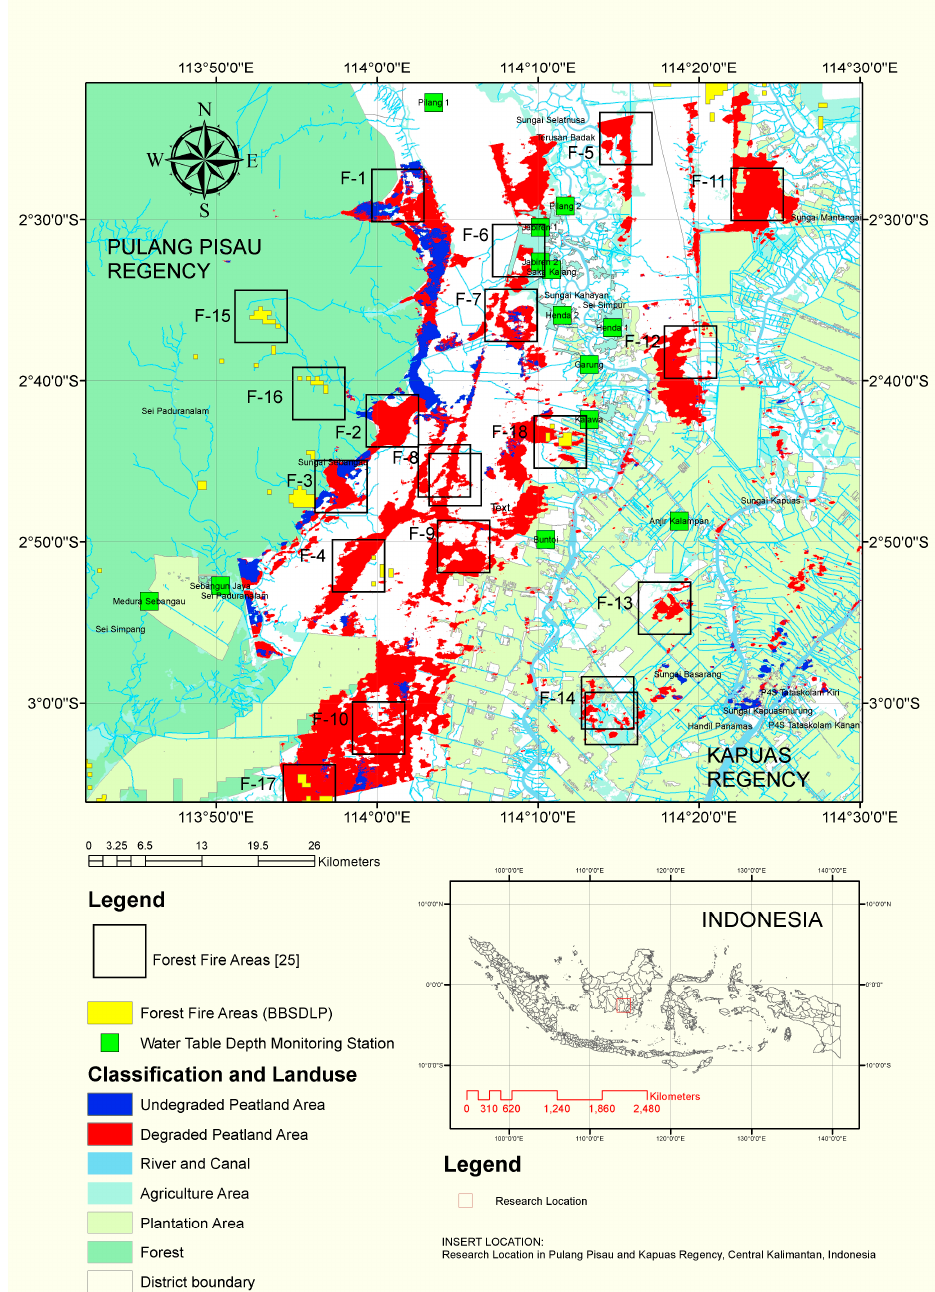
Figure 8. Degraded peatland areas based on SAR interferometry, water table (WT) depth monitoring system, and peat fire of research area based on Indonesian Center for Agricultural Land Resources (BBSDLP) and previous research study [25].